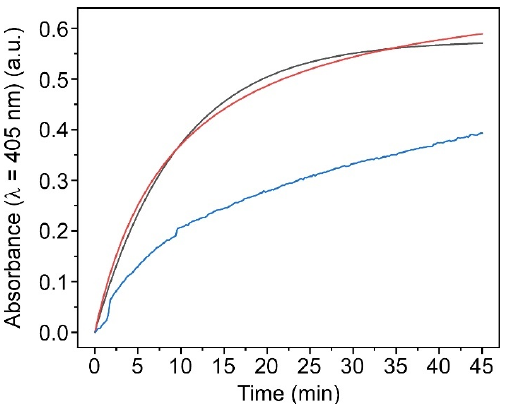
Figure 5. Kinetics of PNP production by alkaline phosphatase in ALP@AETA hydrogel (black), xerogel (red) and aerogel (blue) in 50 µM PNPP presence. Samples were placed in quartz cuvettes of 1 cm path length and absorbance values were collected as a function of time at 405 nm.